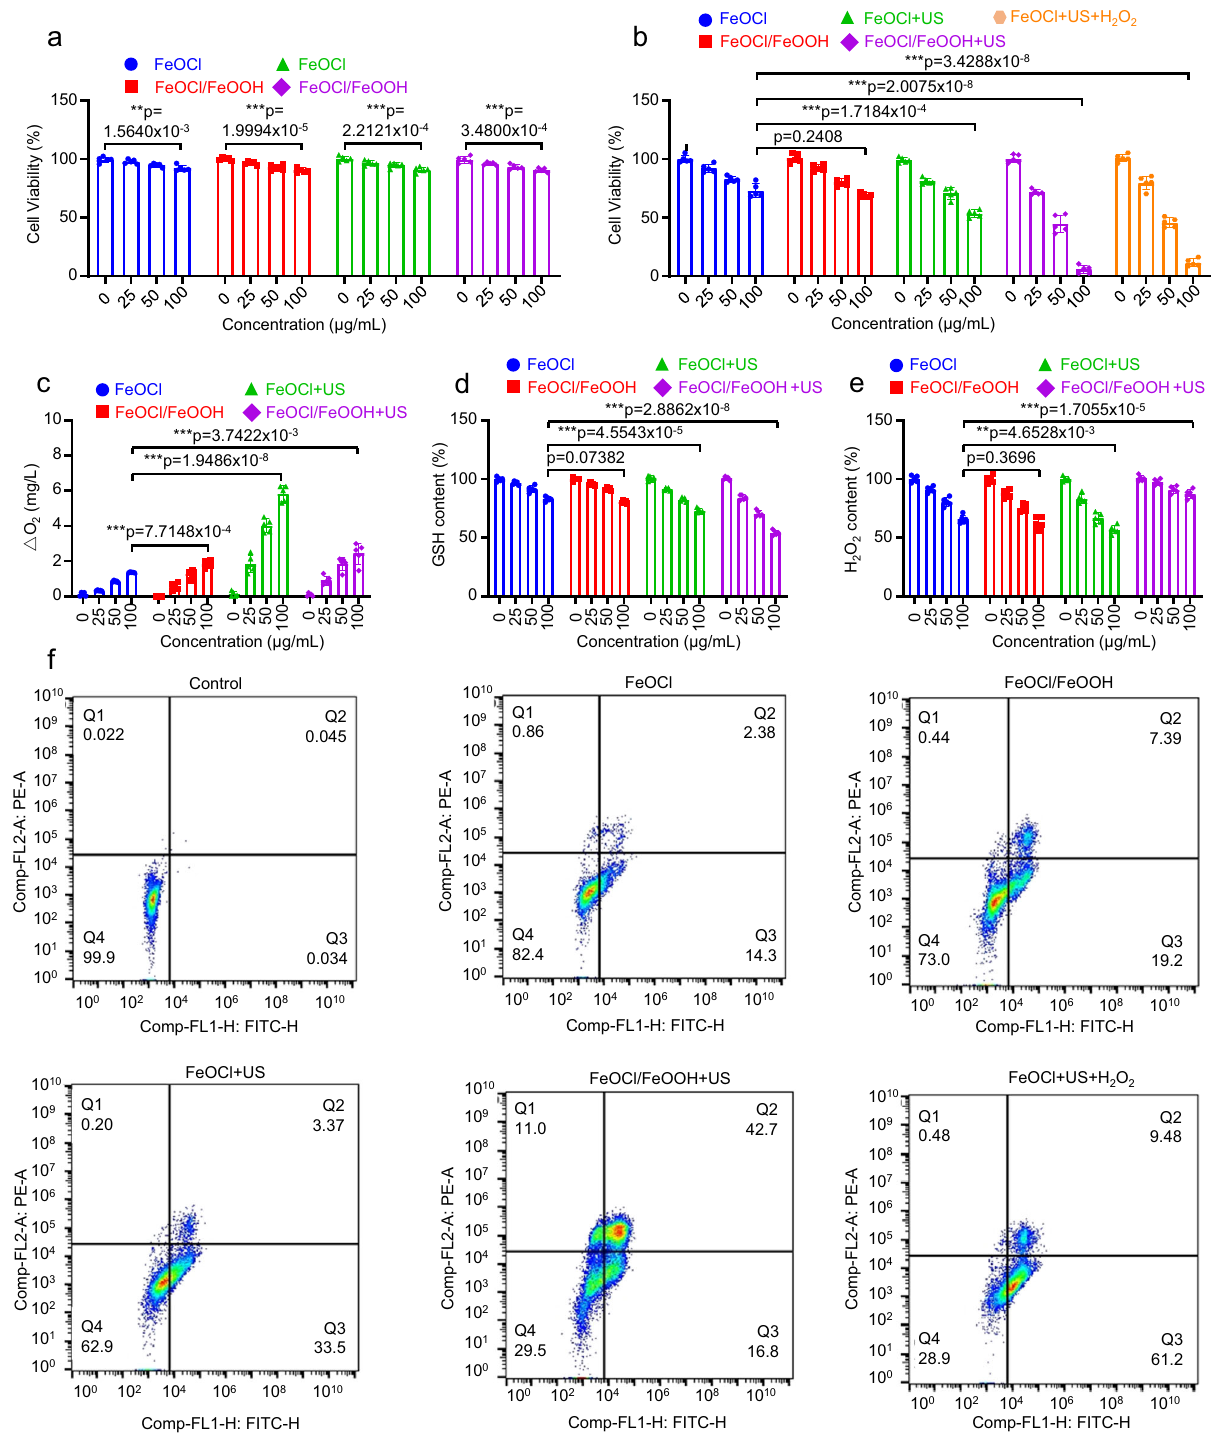
Fig. 6 Biocompatibility and cytotoxicity of FeOCl NSs and FeOCl/FeOOH NSs. a Relative viability of normal human cells (HL-7702 and HEK293) after incubation with FeOCl NSs or FeOCl/FeOOH NSs for 24 h. b Relative viability of MCF7 cells after incubation with FeOCl NSs or FeOCl/FeOOH NSs under different treatments for 24 h. c The generation of O 2 of MCF7 cells after incubation with FeOCl NSs or FeOCl/FeOOH NSs under different treatments. d The degradation of GSH of MCF7 cells after incubation with FeOCl NSs or FeOCl/FeOOH NSs under different treatments. e The consumption of H 2 O 2 of MCF7 cells after incubation with FeOCl NSs or FeOCl/FeOOH NSs under different treatments. f FCM images of MCF7 cells after incubation with FeOCl NSs and FeOCl/FeOOH NSs under different treatments for 12 h. The condition for US treatment is 1 MHz, 1 W cm − 2 , 50% duty cycle, 5 min. Data are presented as mean ± s.d. ( n = 5 biologically independent cells). Statistical differences were analyzed by Student ’ s two-sided t -test. Source data are provided as a Source Data fi le. The information on antibodies for these assays are provided in Supplementary Table